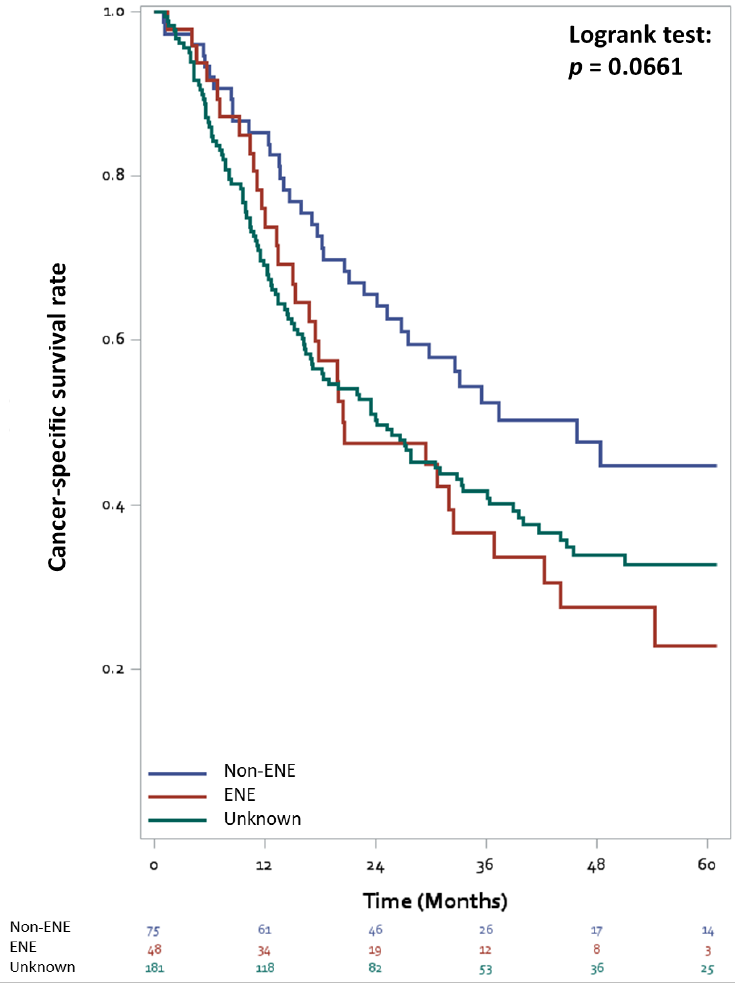
Figure 2. Cancer-specific survival curves stratified by the status of extranodal extension in bladder cancer patients with lymph node involvement treated with radical cystectomy.